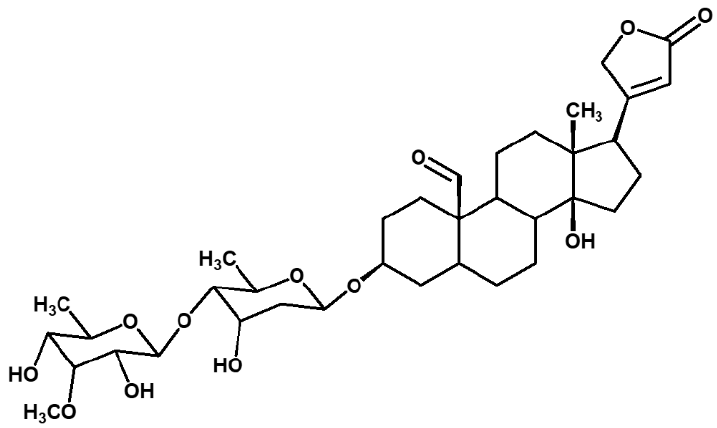
Figure 8. Cardenolide glycoside crotoxigenin-3- O - β -digitalopyranosyl-(1-4)- O - β -digitoxopyanoside, isolated from X. undulatum .